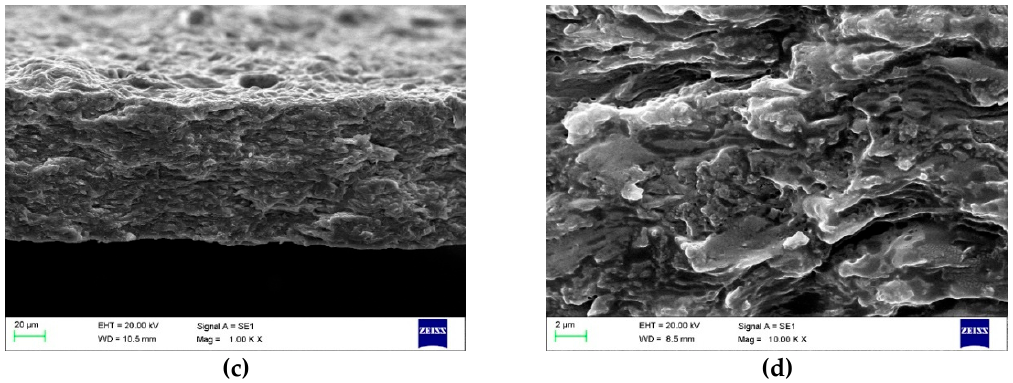
Figure 5. FE-SEM micrographs of film surfaces with a magnification of 1.00 K × ( a ) and 5.00 K × ( b ) and cross-sectional images with a magnification of 1.00 K × ( c ) and 10.00 K × ( d ) containing the highest concentration of maleic anhydride (1.56%) prepared according to the sol-gel-ma method (both glycerol and sugar concentrations were 7%).